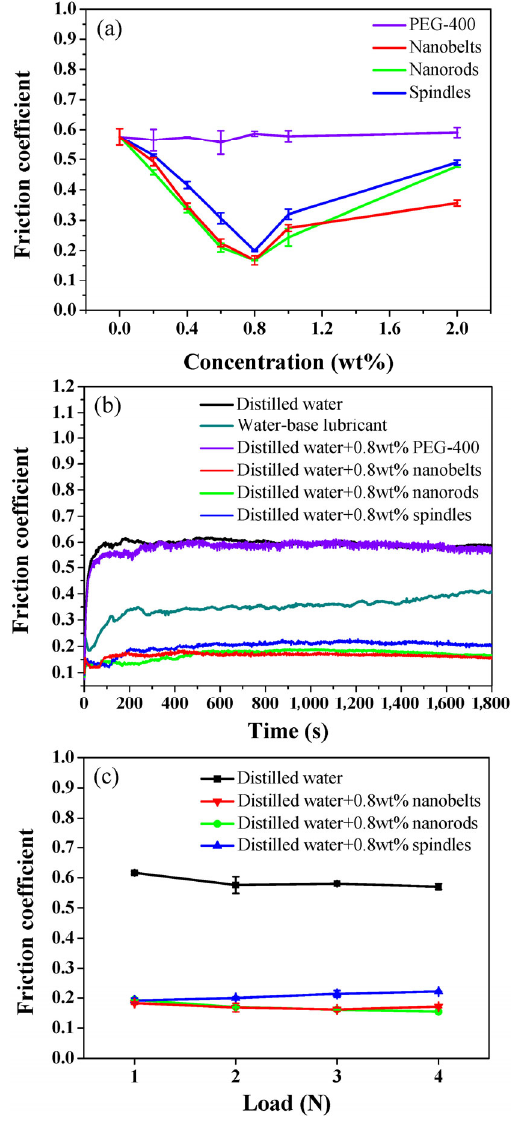
Fig. 8 The results of the friction test. (a) Friction coefficient as a function of concentration, (b) variations of friction coefficient with sliding time, and (c) relationship between friction coefficient and applied